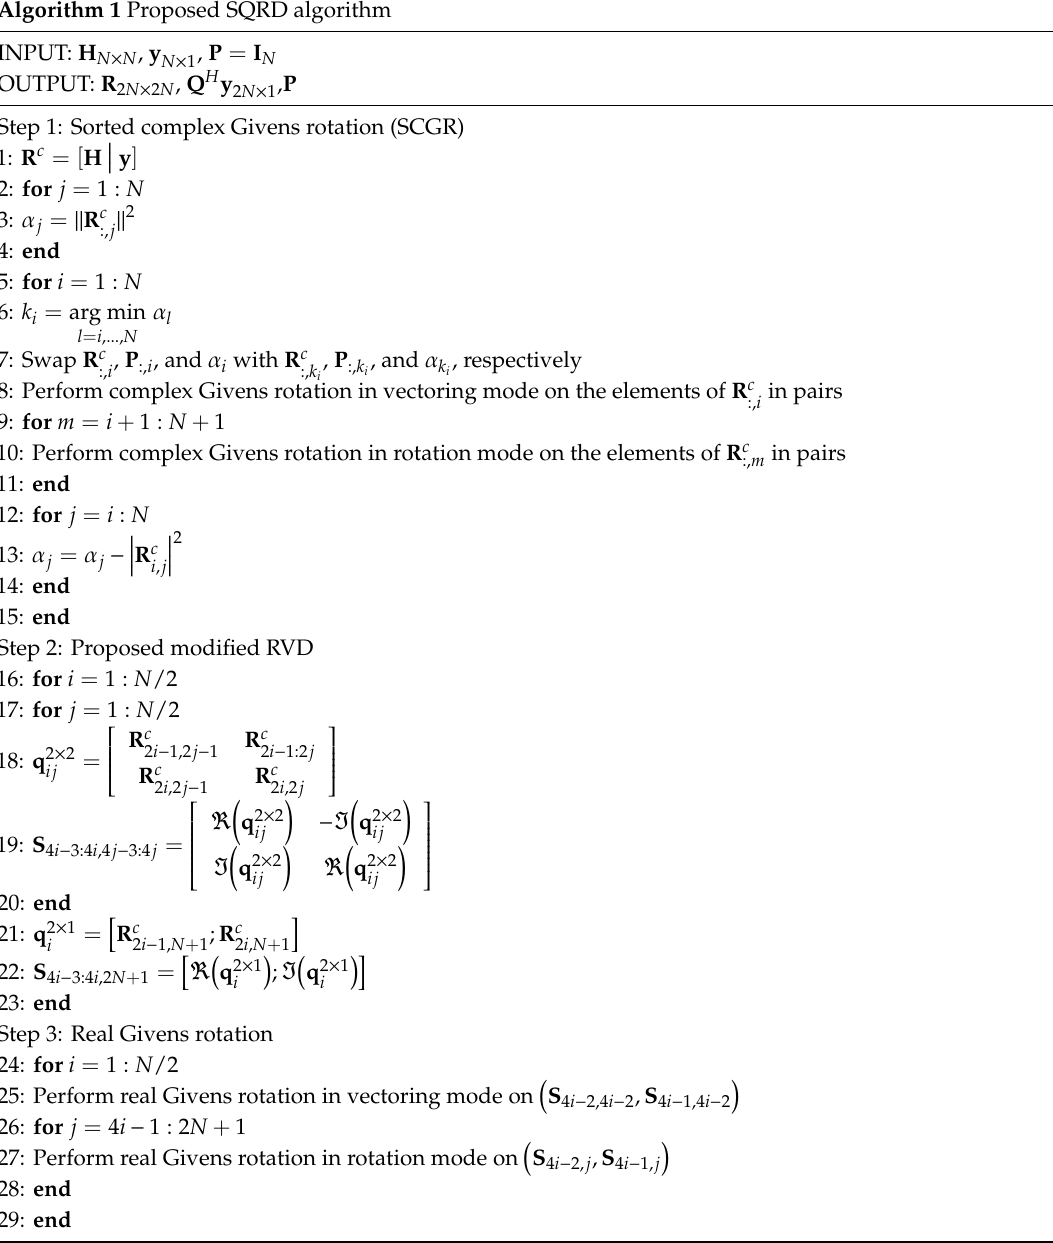
Figure 1. Schematic diagram of the expansion of R c with proposed modified real-value decomposition (RVD). Algorithm 1 Proposed SQRD